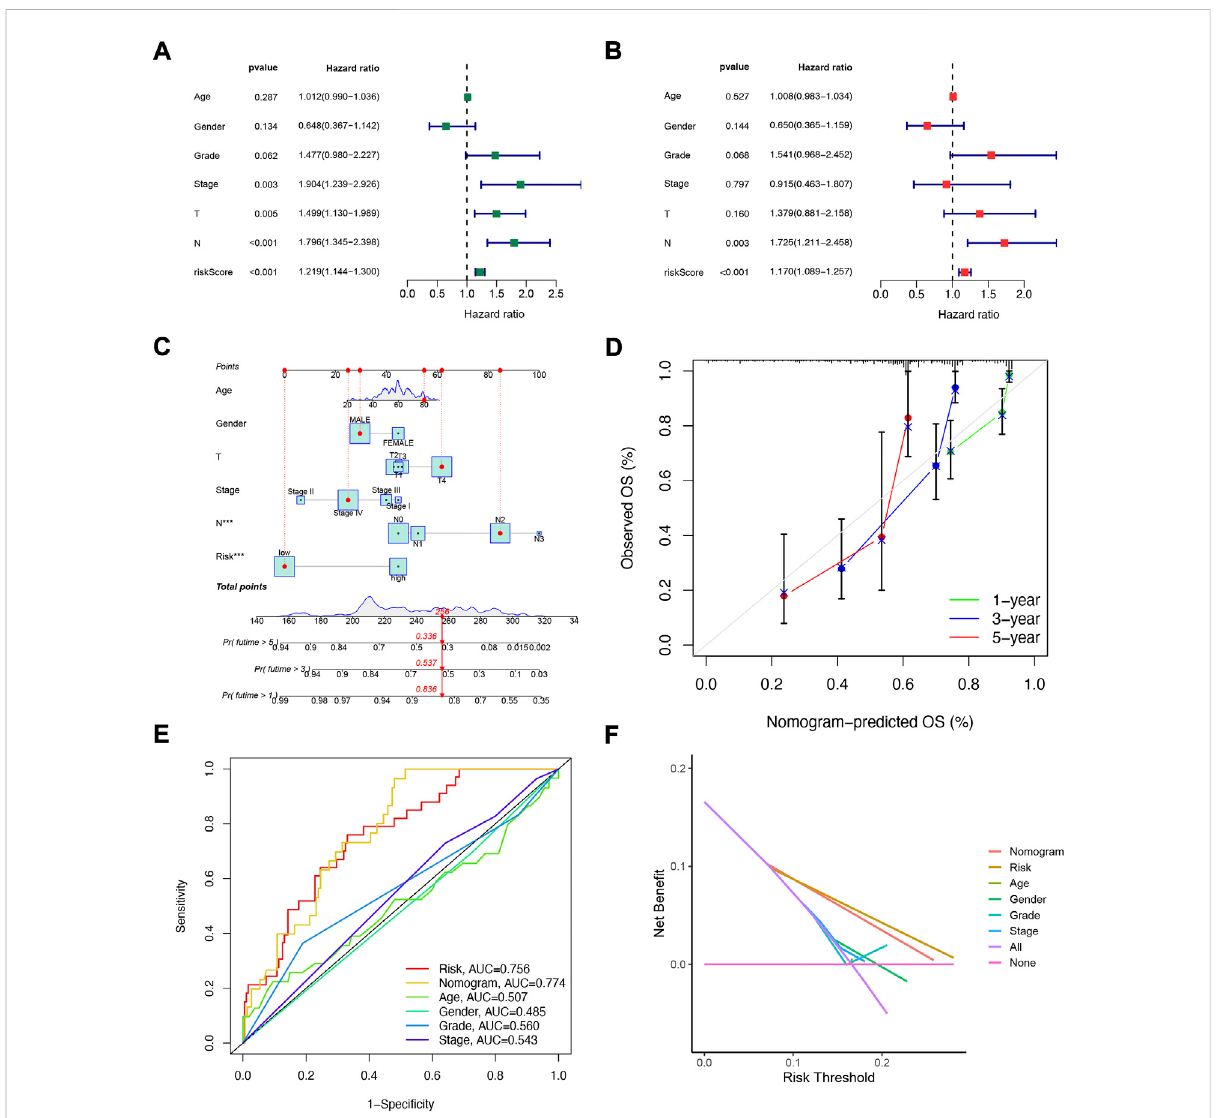
FIGURE 5 Independent prognostic analysis of risk scores and clinical parameters. Univariate (A) and multivariate (B) COX regression analysis of the signatureanddifferentclinicalfeatures. (C) Nomogramforpredicting1-year,3-year,and5-yearOSofpatientswithHNSCC. (D) Thecalibrationcurve of the constructed nomogram of 1- year, 3- year, and 5-year survival. (E) Multi-index ROC analysis in the test cohort. (F) Decision curve